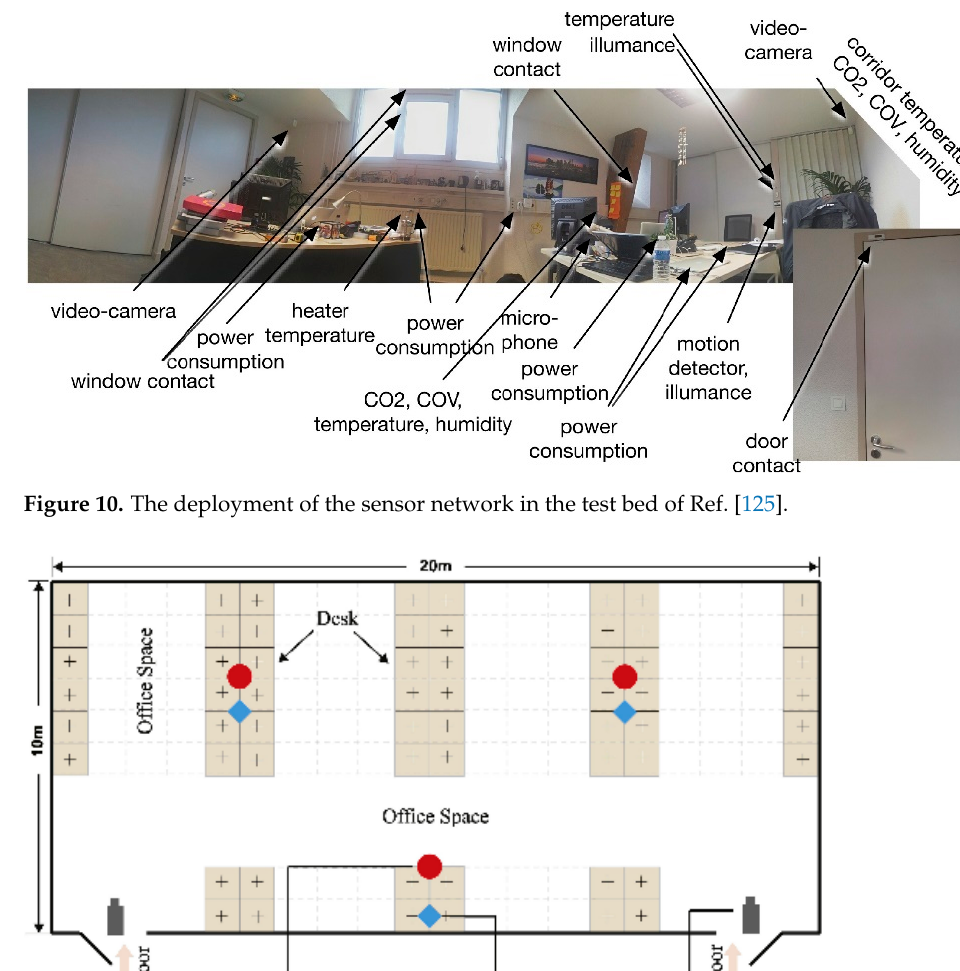
Figure 12. The multimodal sensor fusion framework in Ref. [128]. Aiming to determine the impact of sensor placement on the data accuracy of a fusion of sensing systems, Azizi et al. [129] conducted a study with 18 multi-sensor devices in- stalled in three workplaces. Multiple sensors for detecting PIR, temperature, carbon diox- ide, humidity, and light were put in each device. Their findings indicated that the location of PIR and CO 2 sensors had a significant impact on the accuracy of occupancy detection.